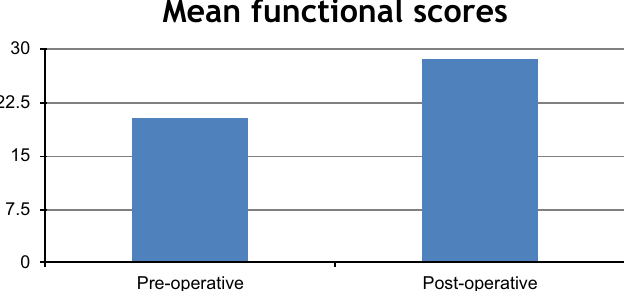
Figure 2. A column chart demonstrating the statistical analysis of the functional scoring